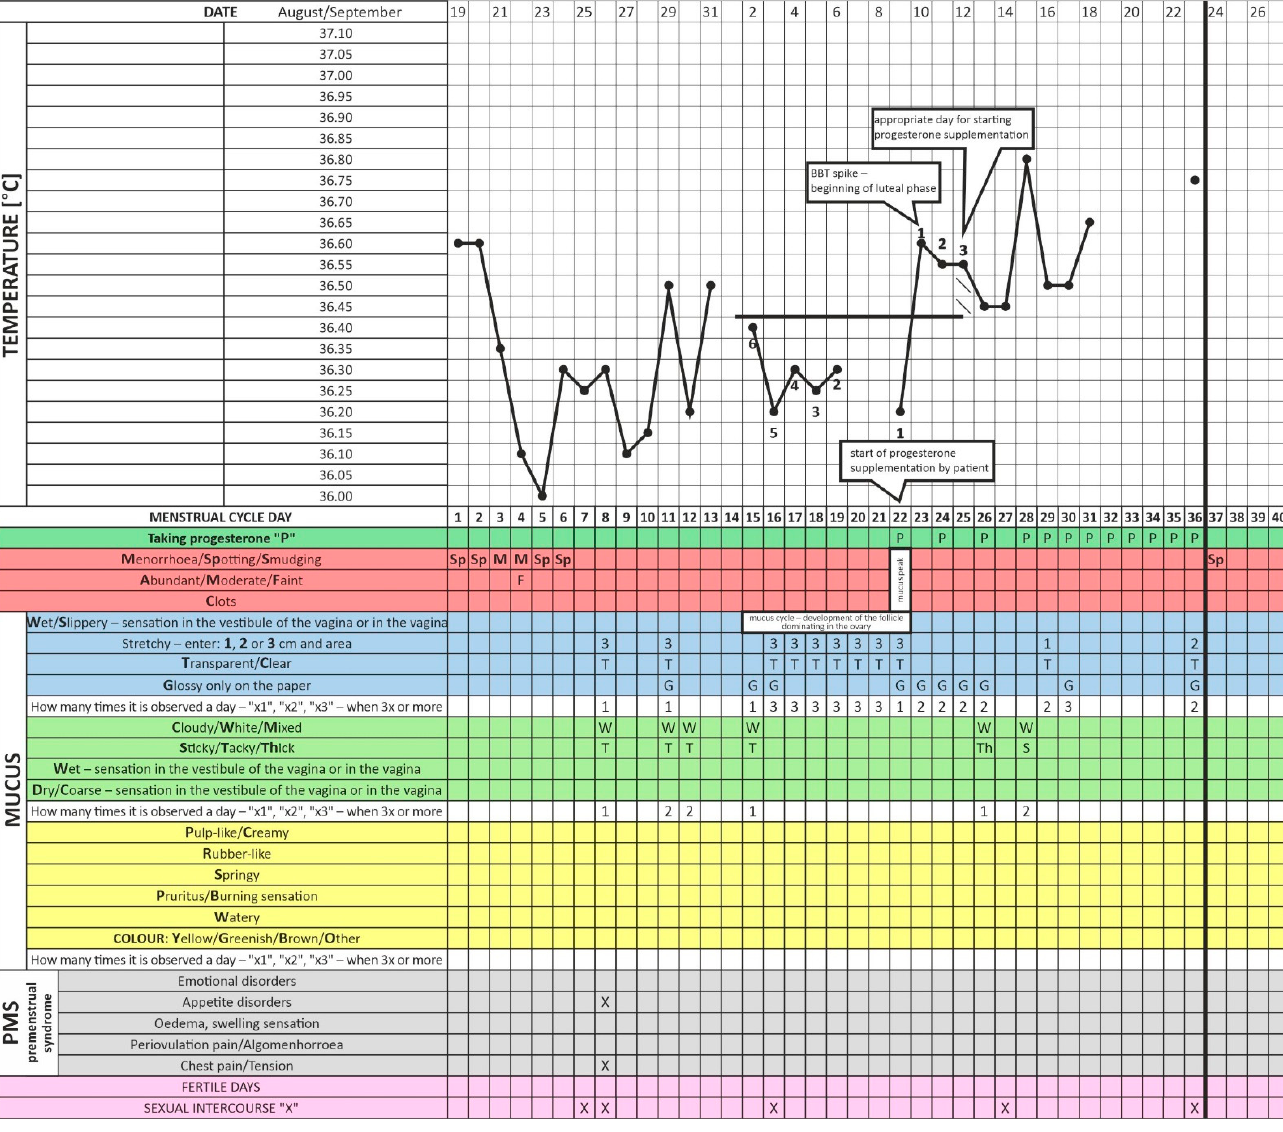
Figure 1. Menstrual cycle observation chart at the time when the patient started taking progesterone incorrectly—too early—(i.e., on Day 22 of the menstrual